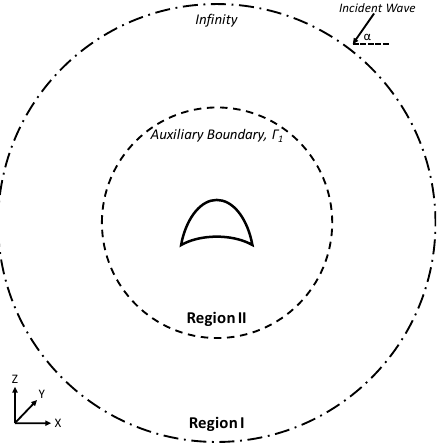
Figure 1. Schematic illustration of the simulation domain, the boundaries, and the crescent-shaped plate.